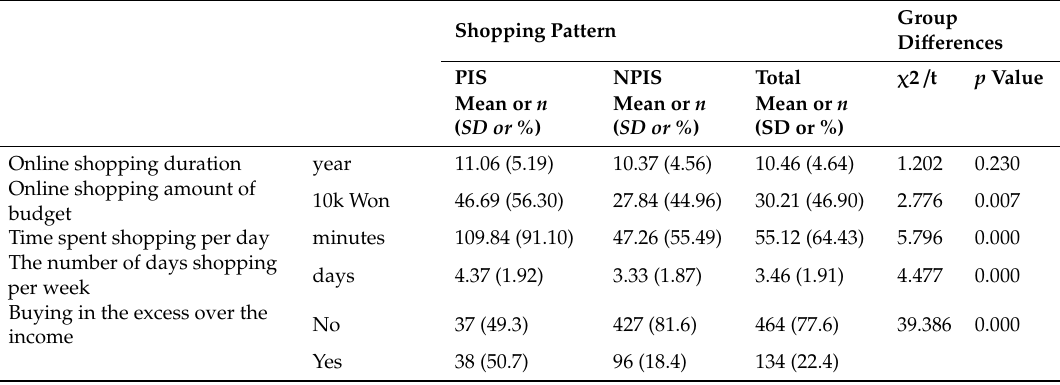
Table 2. Comparisons of online shopping pattern between PIS and NPIS participants.